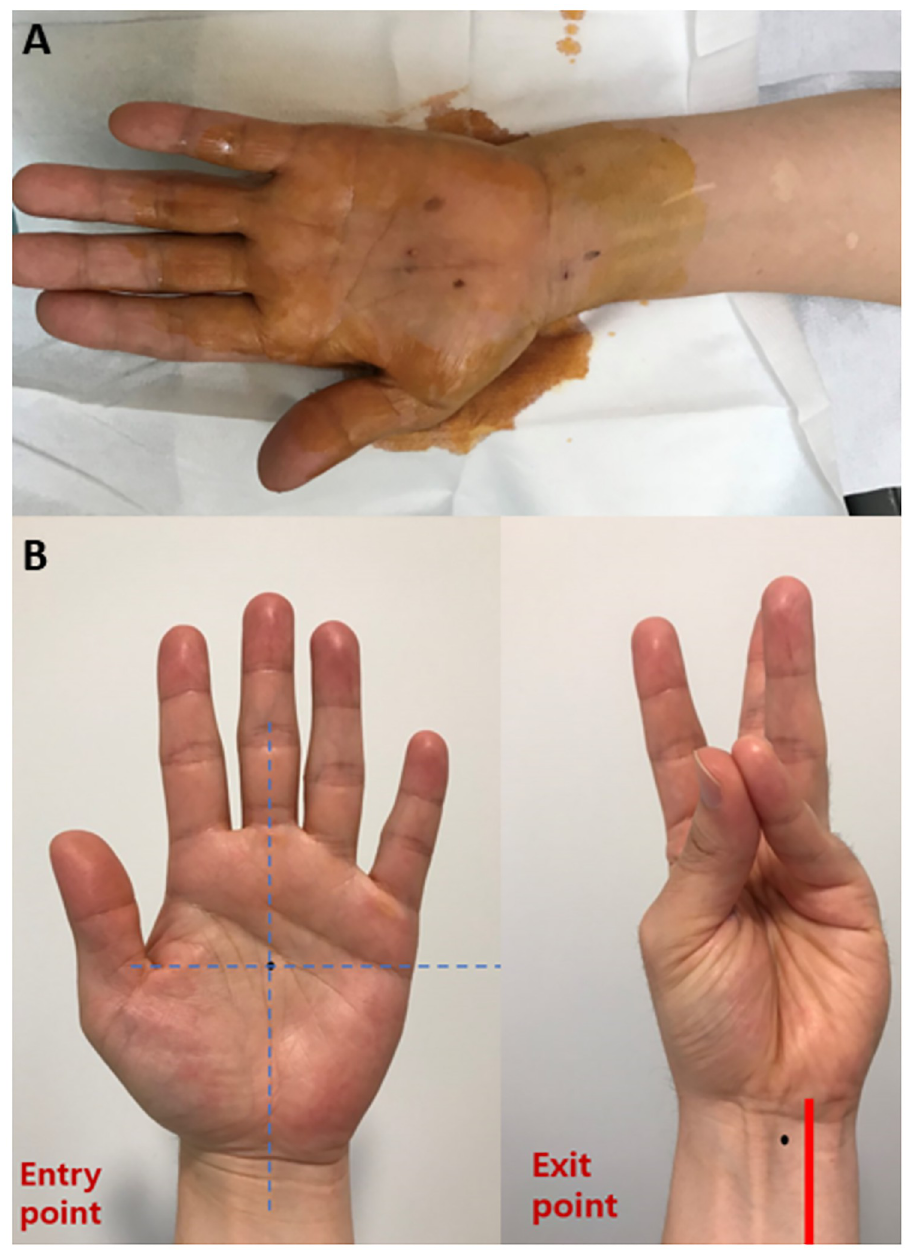
Fig 2. Standardized technique to determine entry and exit points. A: Patients’ upper extremity positioned on an arm board. B: Standardizing methods when marking entry and exit points. was placed just medial to the palmaris longus tendon, 1-2cm proximal to the distal wrist crease, which could be visualized by hand opposition of the thumb and 5 th digit with slight wrist flexion, in order not to damage the ulnar artery (Fig 2). All procedures were performed using an LOGIQ S7 ultrasound machine (GE Healthcare, Seoul, Korea) fitted with a ML6-15 (8 MHz) linear array transducer. With the ultrasound machine fitted, the patient’s structures were examined, and marked entry and exit points were confirmed. The “duck’s beak”